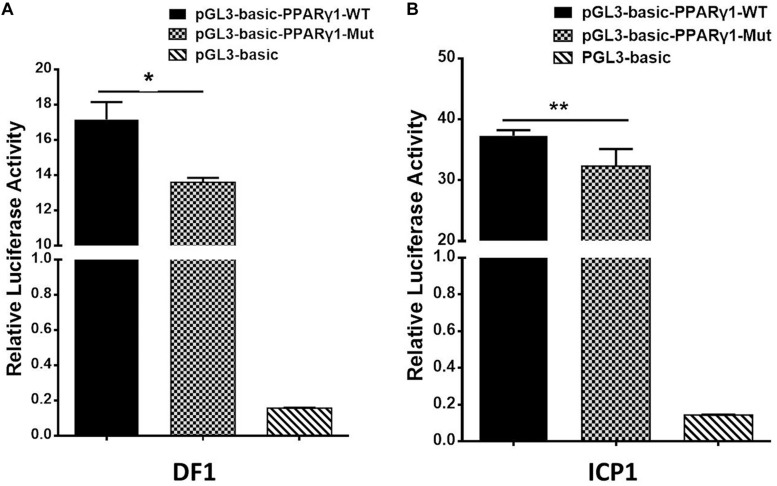
The promoter activity analysis of the DNA sequences corresponding wild-type and uORF-mutated 5′ UTRs of PPARγ1. The DNA sequences corresponding wild-type and uORF-mutated 5′ UTRs of PPARγ1 were cloned into luciferase reporter vector pGL3-basic to yield pGL3-PPARγ1-WT and pGL3-PPARγ1-Mut, respectively. The indicated reporters along with the pRL-TK Renilla luciferase vector were transiently transfected into DF1 (A) and ICP1 cells (B), and the luciferase activity was determined at 48 h after transfection. The pRL-TK vector was used for normalization of transfection efficiency. All data represent the mean ± SEM. *P < 0.05, **P < 0.01, Student’s t-test.